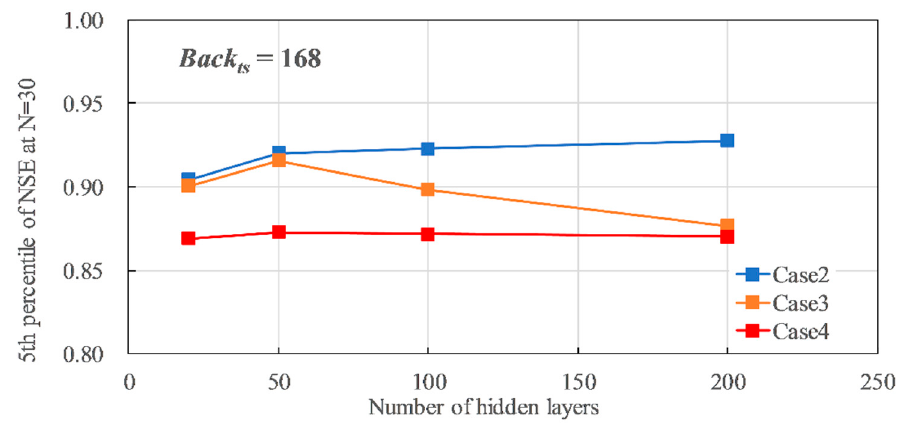
Figure 15. Influence of number of hidden layers on the 5th percentile of NSE, when Back ts = 168.